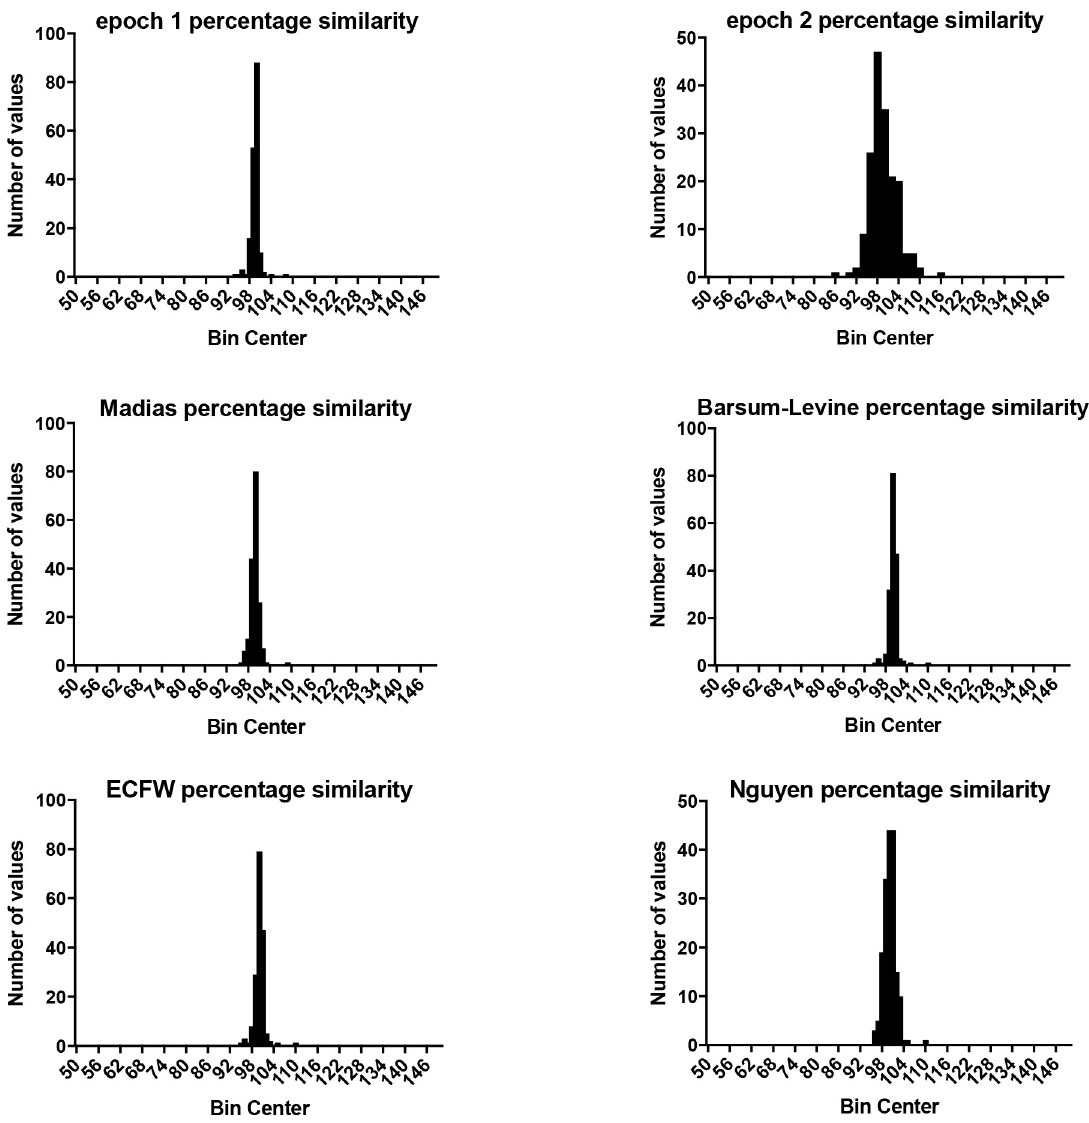
Fig 4. Comparison of the predictive power of our equation with other existing formulae with the statistical model of the percentage similarity. A) epoch 1, B) epoch 2 period, C) Madias equation, D) Barsoum-Levine equation, E) EFWC equation, and F) Nguyen-Kurtz on our